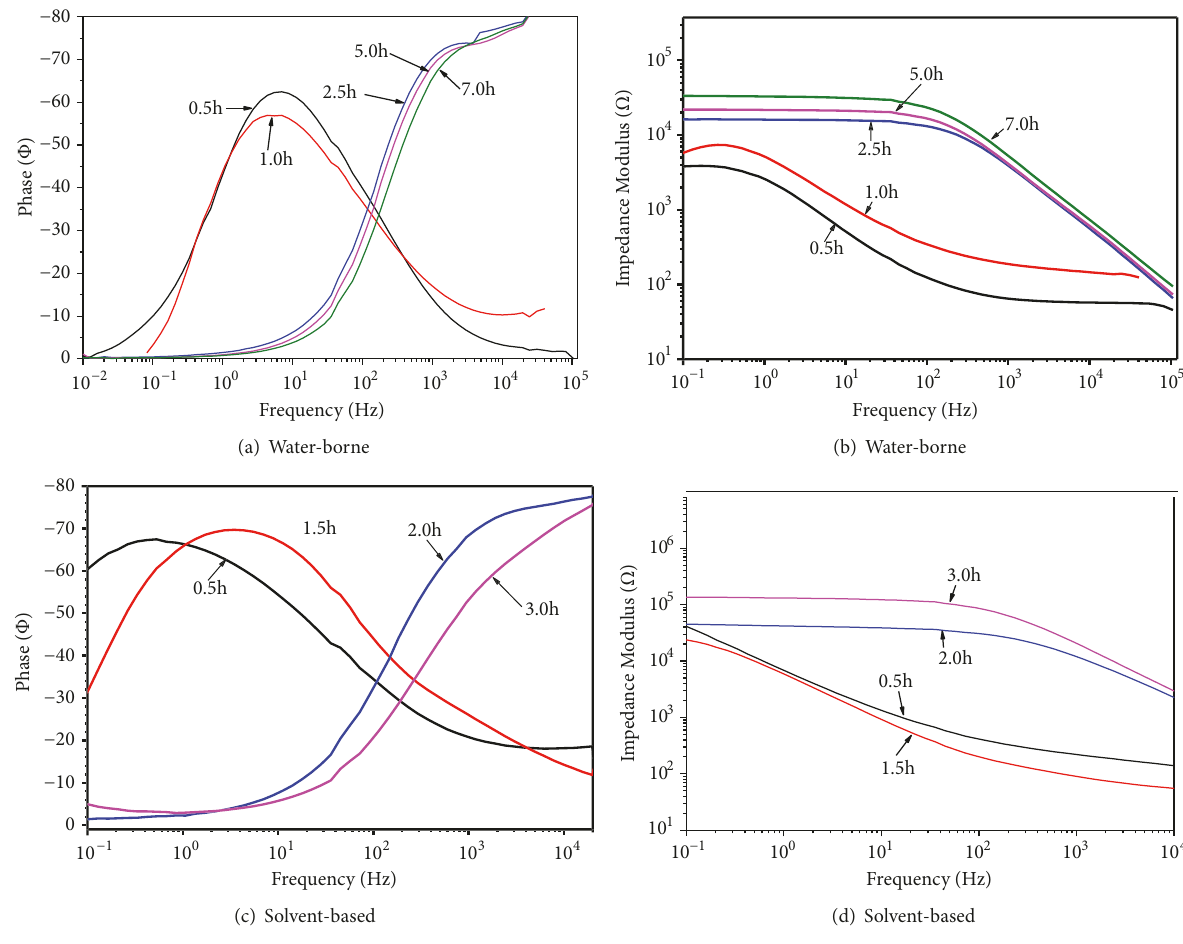
Figure 7: EIS Bode plots for films prepared with different formation